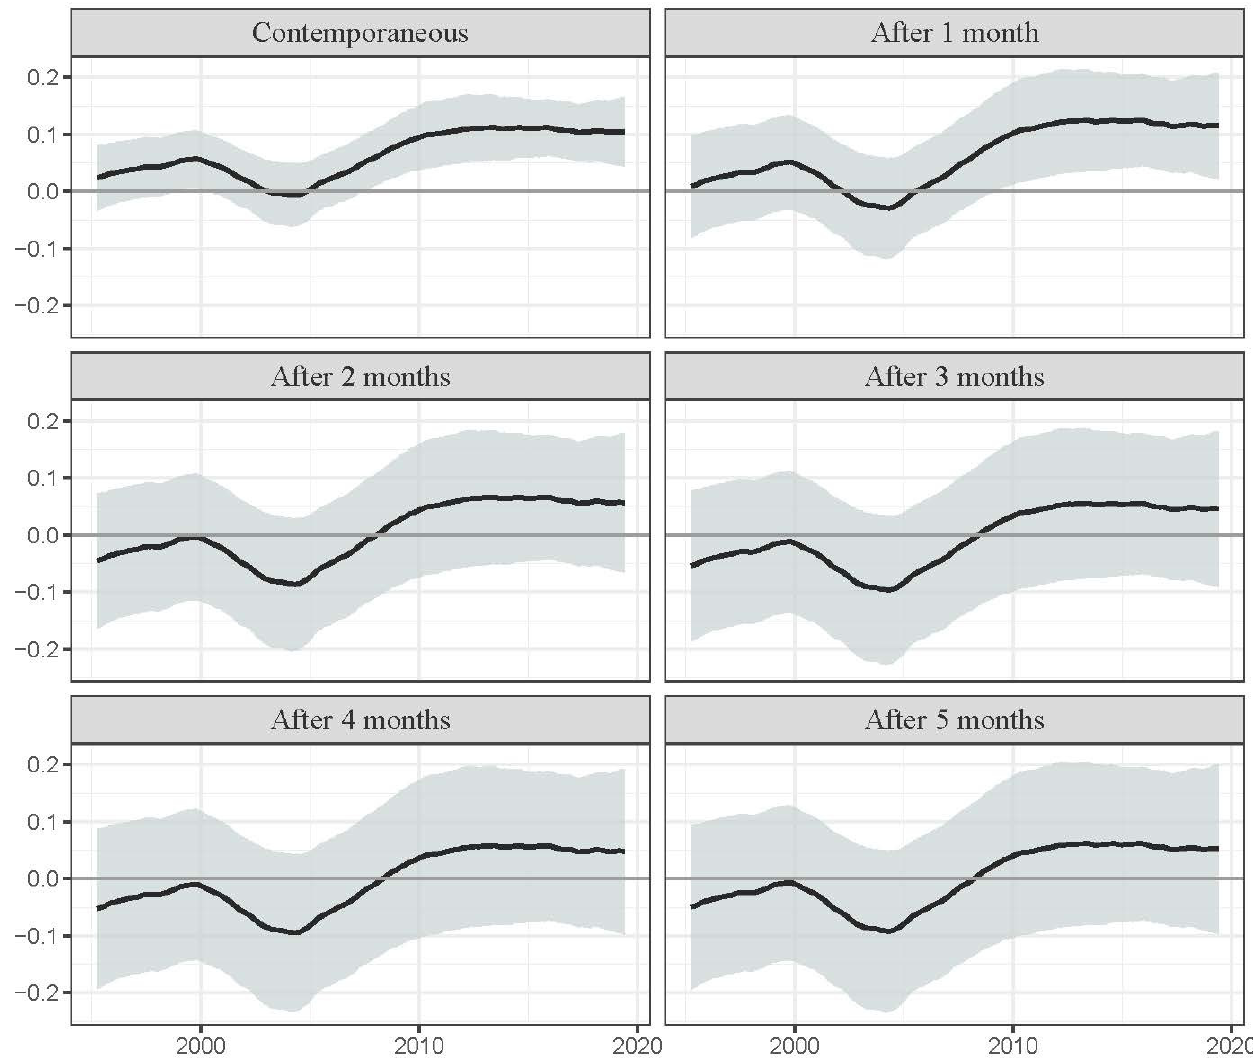
Figure 6. Responses of stock returns to an oil-specific demand shock. Note: This figure presents the accumulated responses of stock returns to a one-unit oil-specific demand shock in the first five months after the shock (1995:04–2019:06). The solid black line shows the mean while the gray area displays the 16th and 84th percentiles.